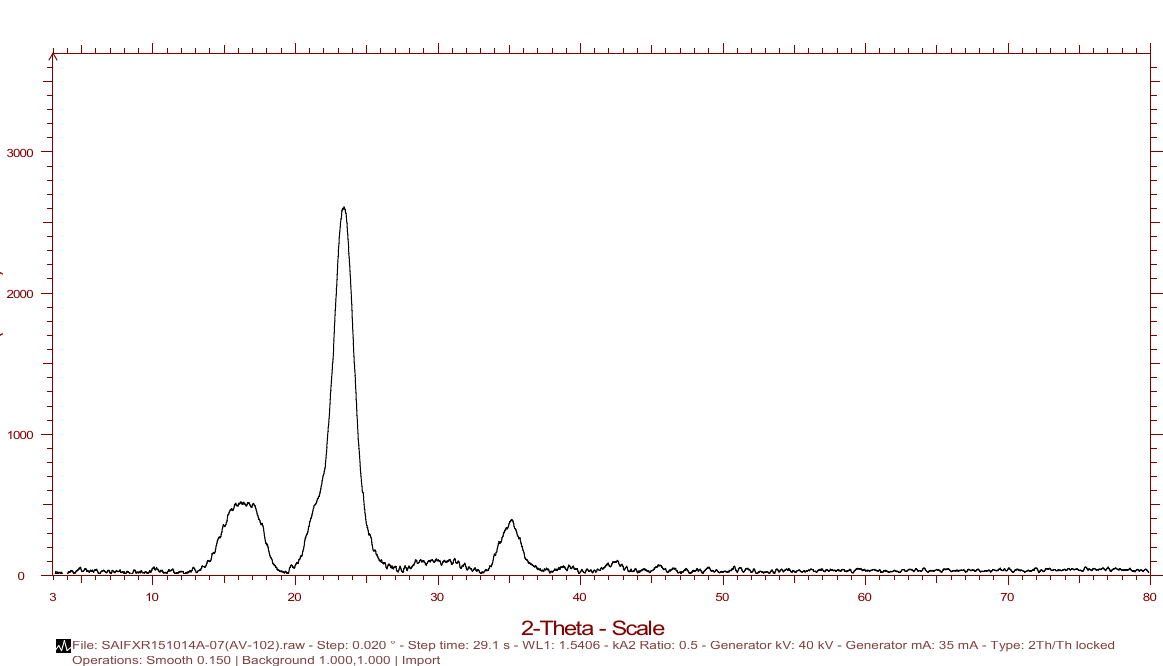
FIGURE 1 - X-ray diffractograms of AV-102, MCC-GossL and MCC-GossF.